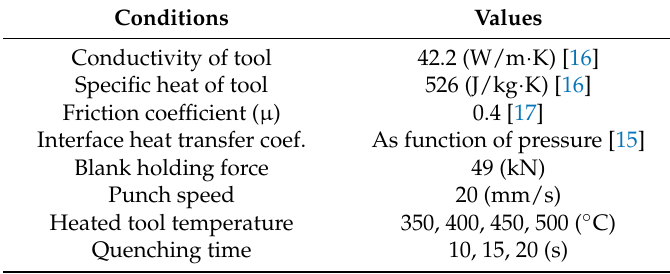
Figure 3. Finite element (FE) model of hat-shaped part for prediction of hardness. Table 3. Conditions for FE simulation.